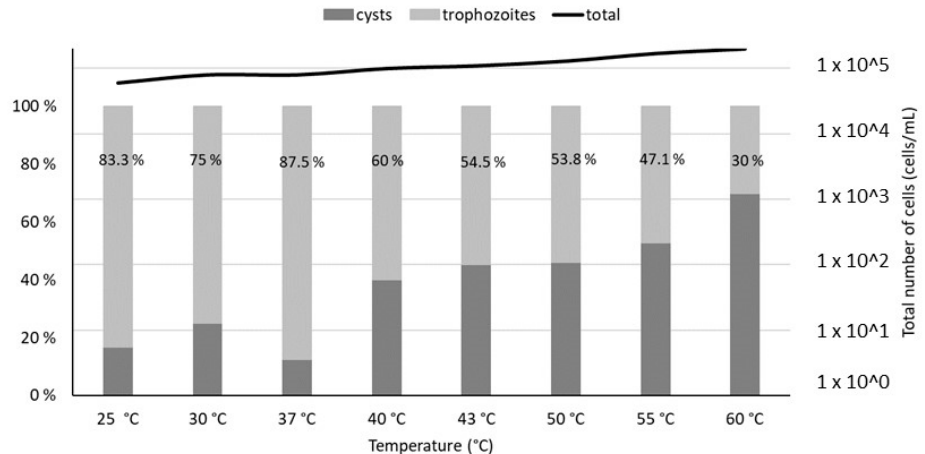
Figure 2. Trophozoites and cysts percentages estimated by optical microscopy (100 × magnification), after a 4 h thermal treatment of V. vermiformis suspensions at temperatures from 25 °C to 60 °C. The percentages of trophozoites in the total V. vermiformis population are indicated on the graph. The line represents the total population of amoebae in each sample.